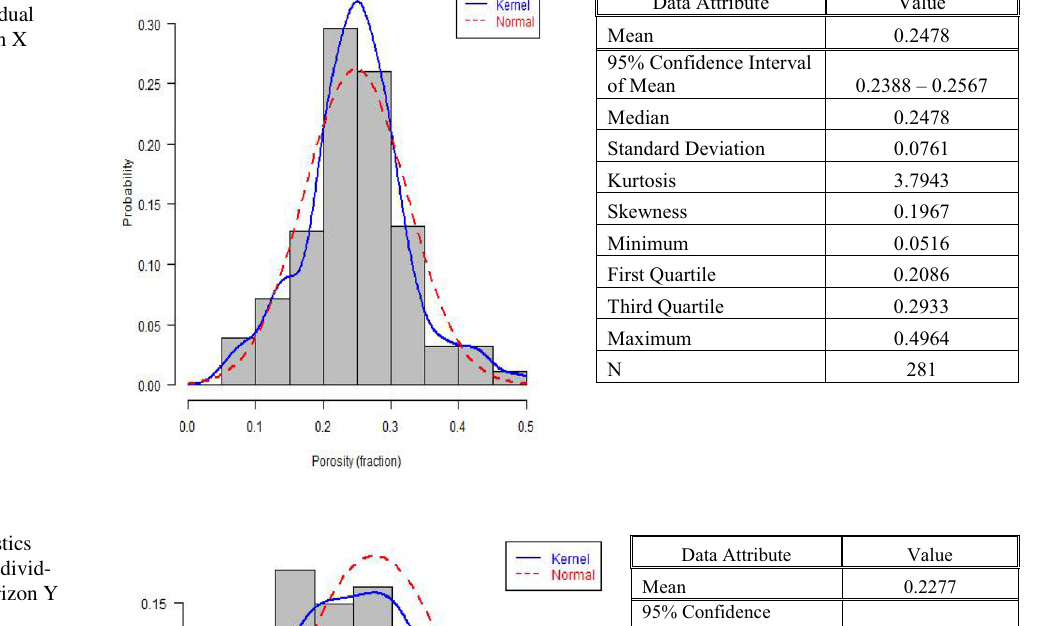
Fig. 9 Descriptive statistics and distributions of all individual porosity values—Horizon X